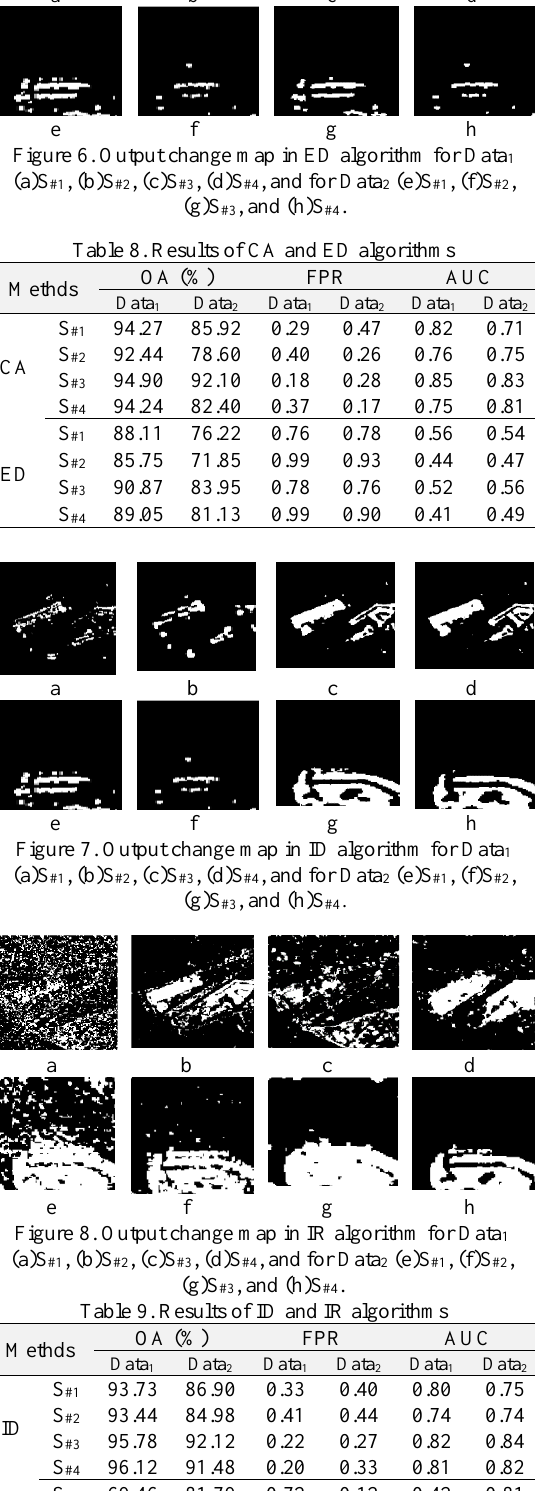
Table 9. Results of ID and IR algorithms